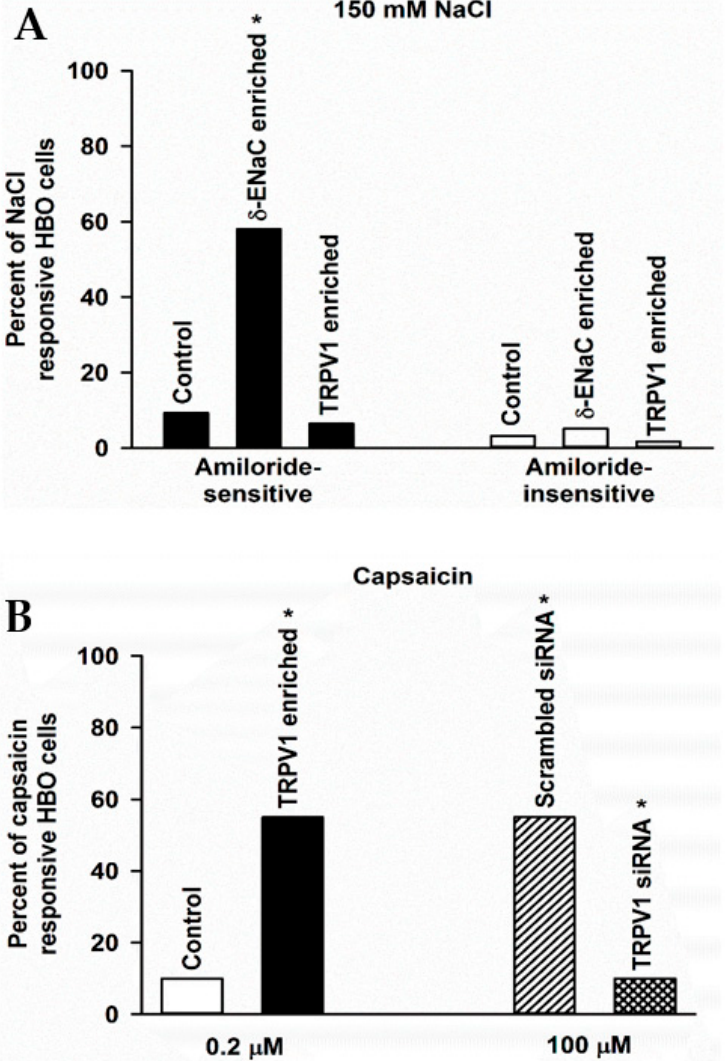
Figure 9. Effect of δ -ENaC enrichment, TRPV1 enrichment, and TRPV1 siRNA on number of NaCl and capsaicin (CAP) responsive HBO cells: ( A ) amiloride-sensitive (AS) and amiloride-insensitive (AI) responses to 150 mM NaCl in single HBO cells using calcium imaging. In 11 independent experiments under control conditions, out of 600 HBO cells investigated, 9.3% of cells demonstrated AS NaCl response, while 3.2% of cells demonstrated AI NaCl response. In 6 separate experiments following δ -ENaC enrichment, out of 286 HBO cells investigated, 166 cells (58%) demonstrated AS NaCl response. While in 5 separate experiments, out of 134 HBO cells examined, 7 cells (5%) demonstrated AI NaCl response. Thus, δ -ENaC enrichment produced a 6-fold (* p < 0.001) increase in AS-NaCl response in HBO cells. Following TRPV1 enrichment, in 3 separate experiments, out of 180 HBO cells examined, 6.5% of the cells demonstrated AS NaCl response, while 1.7% of the cells demonstrated AI NaCl response. ( B ) Changes in [Ca 2+ ] i , in single HBO cells using calcium imaging in HBO cells treated with CAP, scrambled siRNA, or TRPV1 siRNA. Following treatment with 0.2 µM CAP, 10% of control HBO cells and 55% of TRPV1-enriched cells responded with an increase in [Ca 2+ ]i. Thus, TRPV1 enrichment produced a 5.5-fold (* p < 0.001) increase in CAP-responsive HBO cells. Following treatment with 100 µM CAP, out of 148 un-transfected HBO cells examined, 82 cells (55%) demonstrated an increase in [Ca 2+ ]i. In contrast, out of 242 TRPV1 siRNA treated HBO cells investigated, 24 cells (10%) demonstrated a CAP-induced increase in [Ca 2+ ]i. Thus, TRPV1 siRNA produced a 5.5-fold (* p < 0.001) decrease in CAP-responsive HBO cells.